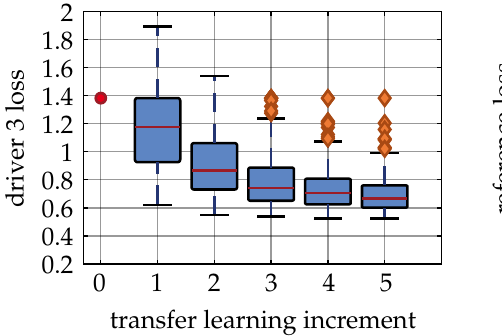
Figure 10. Training results for driver 3 (dynamic).